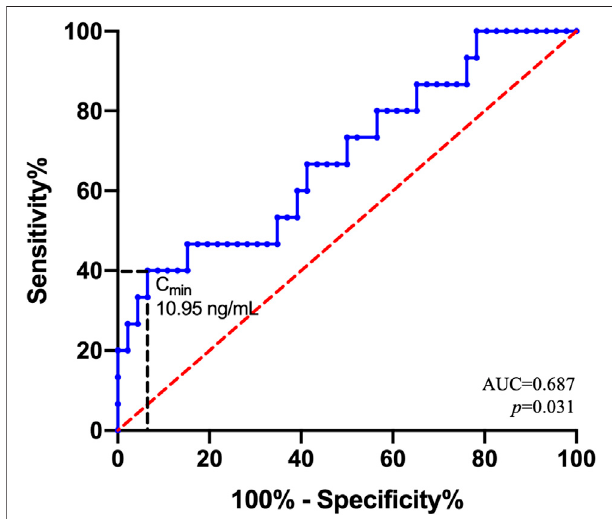
FIGURE 3 | Receiver operating characteristic (ROC) curve for hematological toxicity. ROC curve estimates for the 61 patients. AUC is the area under the ROC curve. With regard to the C min threshold value of 10.95 ng/mL, the sensitivity and speci fi city were 0.4 and 0.935,